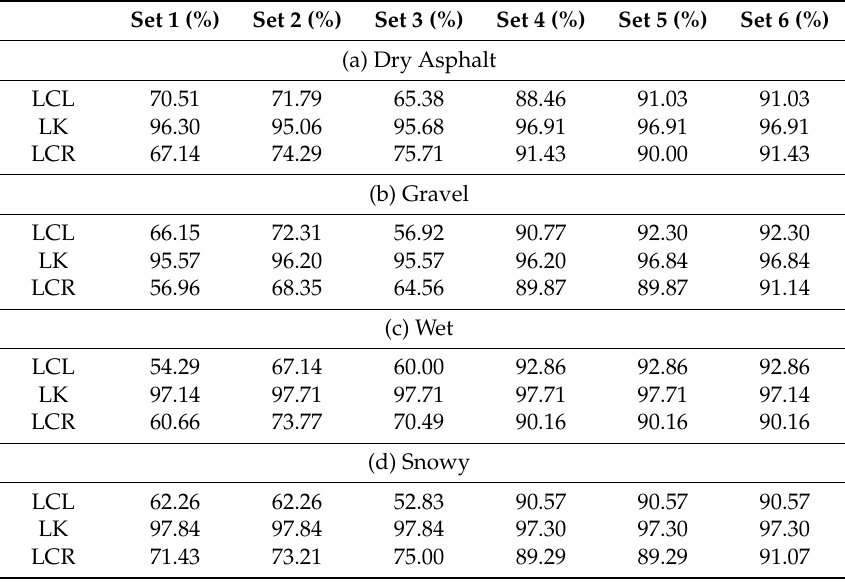
Table 5. Detection accuracy in four different road